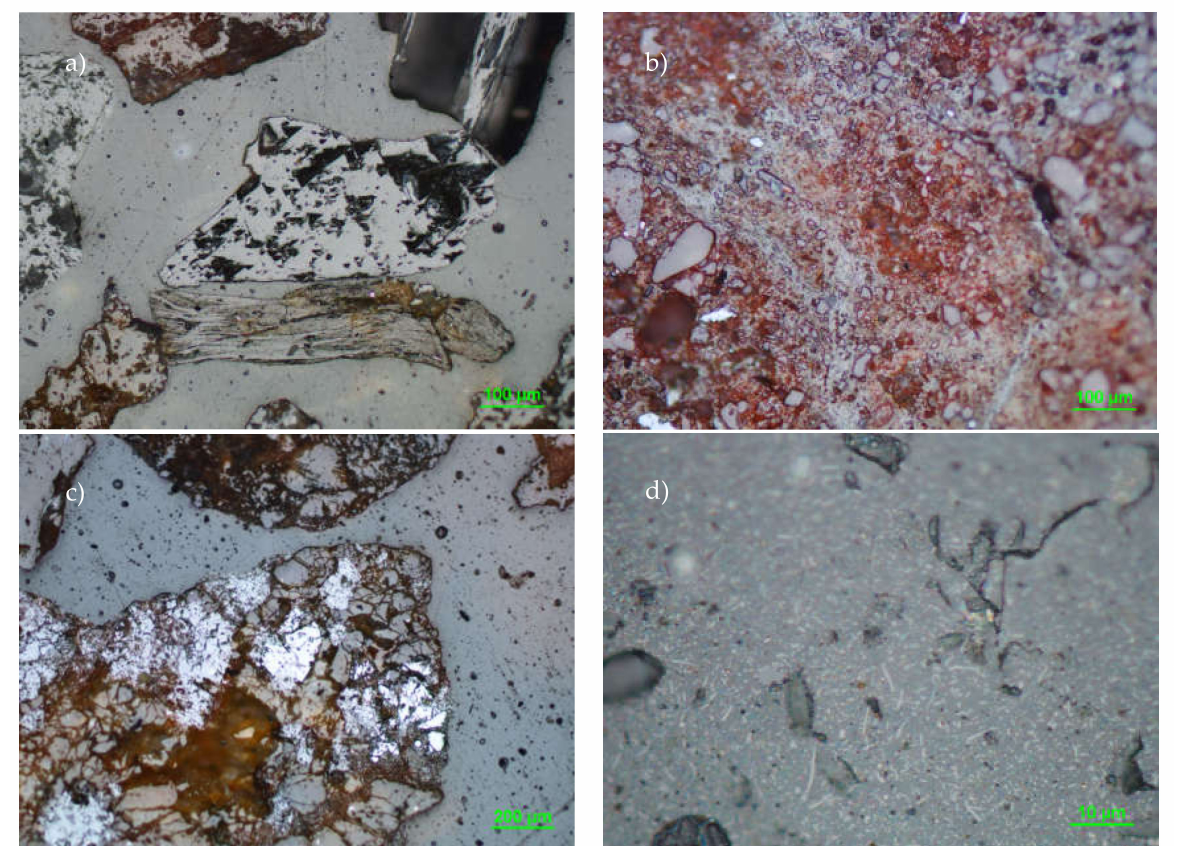
Figure 2. Light photomicrographs of some of the minerals present in the soil samples. ( a ) Galena (sometimes this mineral is partially replaced by cerussite), ( b ) hematite disseminations (average grain size from 10 to 20 µ m) which are commonly found in small particles associated with metamorphic fragments, ( c ) pyrite (also this mineral is frequently partially replaced by cerussite), and ( d ) rutile disseminations in the form of altered needles (10 µ m in